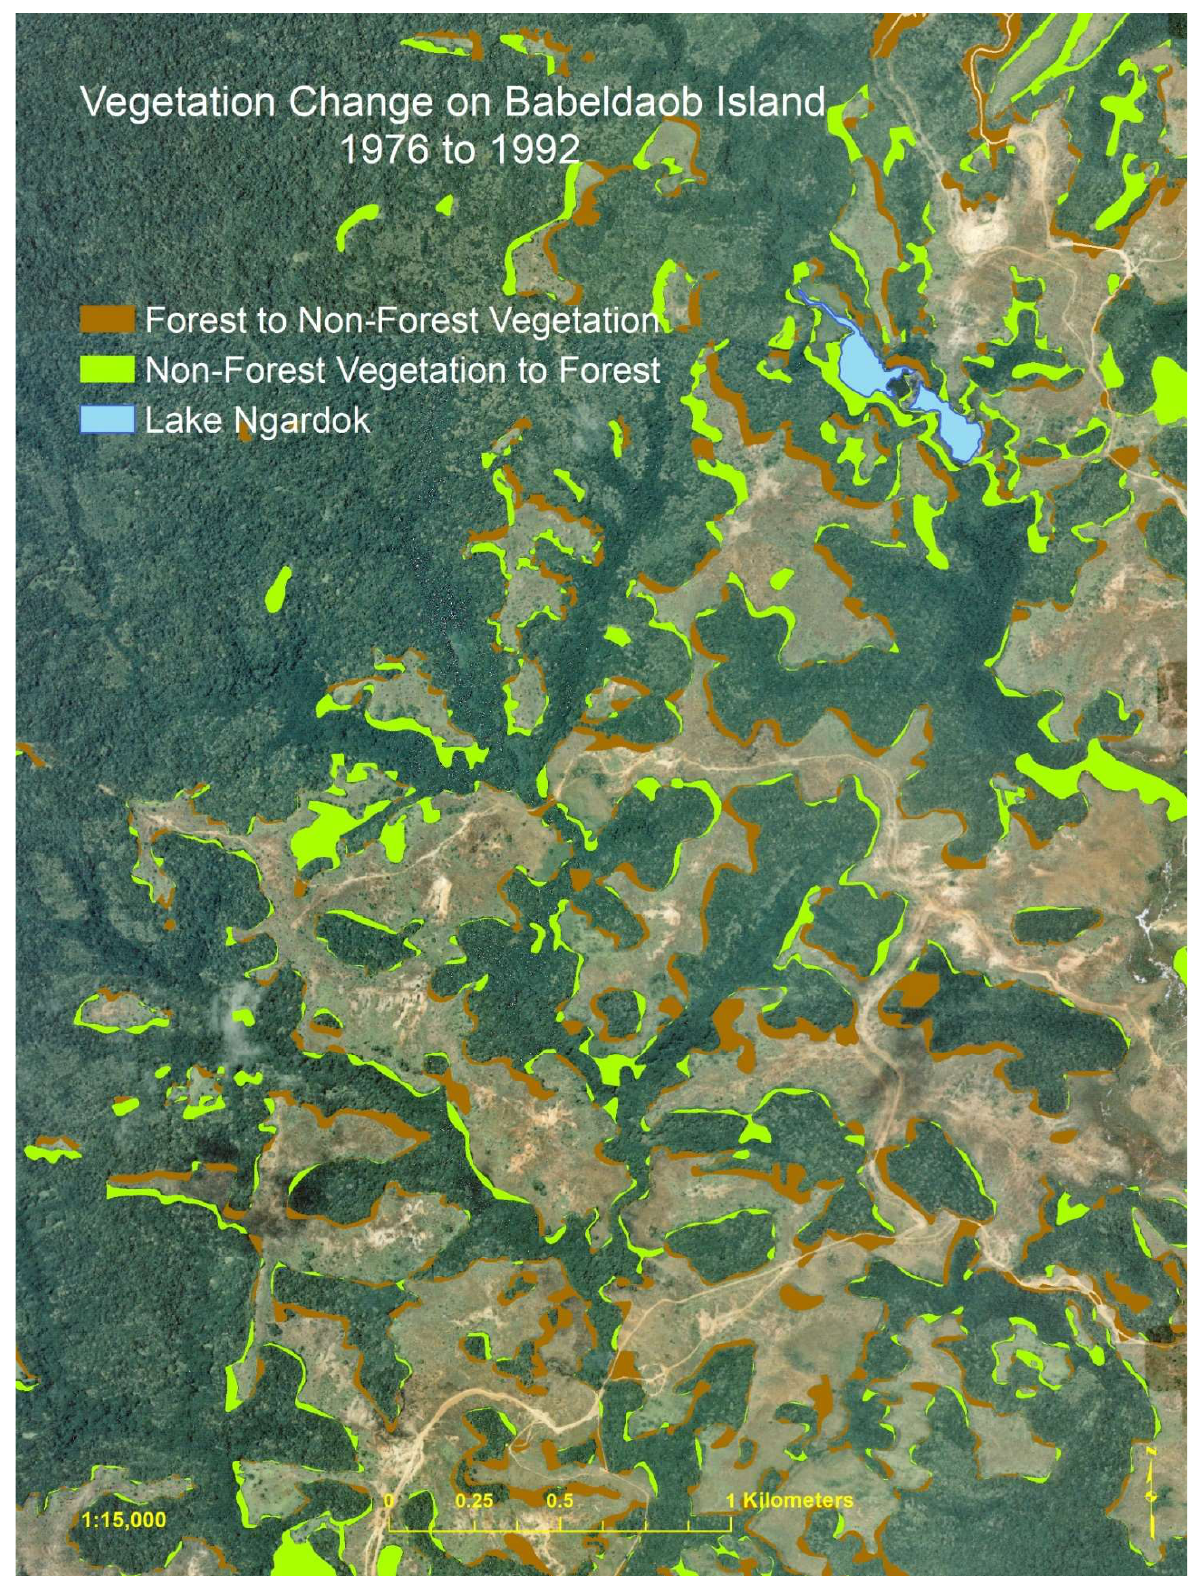
Figure 5. A 10× zoom view of Babeldaob Island, Palau showing forest and non-forest vegetation cover changes in the area south of Lake Ngardok in Melekeok State between 1976 and 1992, overlaying the 1992 aerial photo base map .